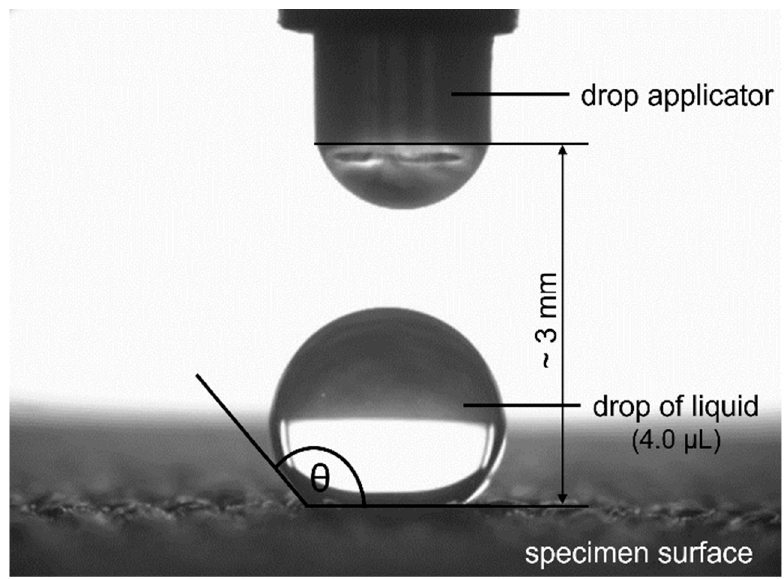
Figure 3. Measurement of contact angle.